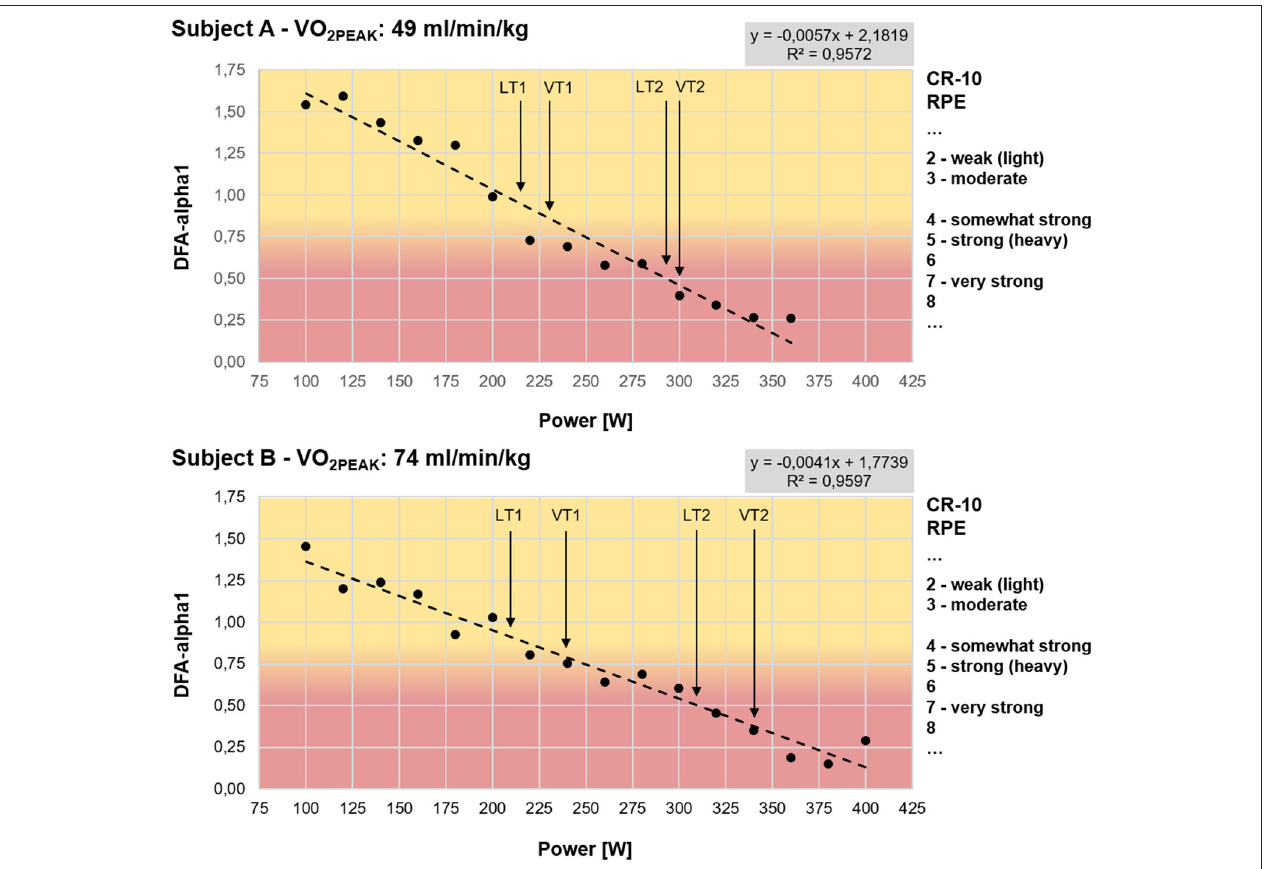
FIGURE 2 | Test results of two subjects during a graded cycling exercise test until voluntary exhaustion with additional information to rating of perceived exertion (RPE) according to CR-10 scale from Borg (1982), lactate and ventilatory thresholds and a colored transition zone around DFA-alpha1 of 0.75 (start: 100W, increment: 20W, stage duration: 3min). Subject A with a maximum achieved wattage of 360W and VO 2PEAK of 49 ml/min/kg (LT1: 217W, VT1: 230W, LT2: 294W, VT2: 300W); Subject B with a maximum achieved wattage of 400W and VO 2PEAK of 74 ml/min/kg (LT1: 210W, VT1: 240W, LT2: 310W, VT2: 340W). Lactate thresholds were determined according to Dickhuth et al. (1999) and ventilatory thresholds were determined according to Gaskill et al. (2001) and Binder et al. (2008); DFA-alpha1: short-term scaling exponent alpha1 of detrended fluctuation analysis, VO 2PEAK : maximum oxygen uptake achieved in the graded exercise test, LT1: first lactate threshold, LT2: second lactate threshold, VT1: first ventilatory threshold, VT2: second ventilatory